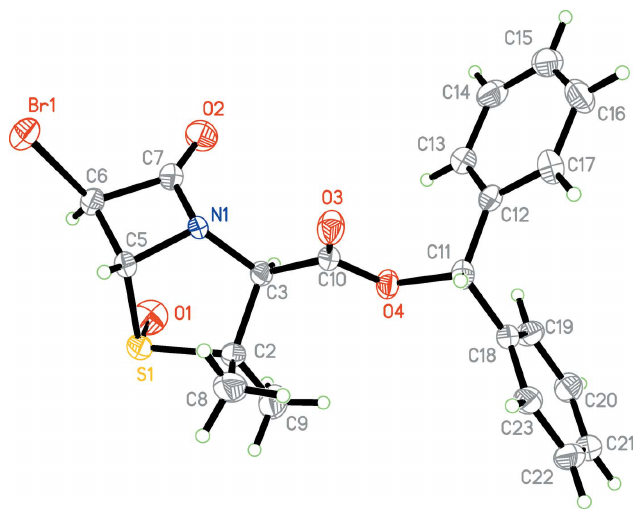
Figure 1 The molecular structure of the title compound with atom labels and 50% probability displacement ellipsoids.